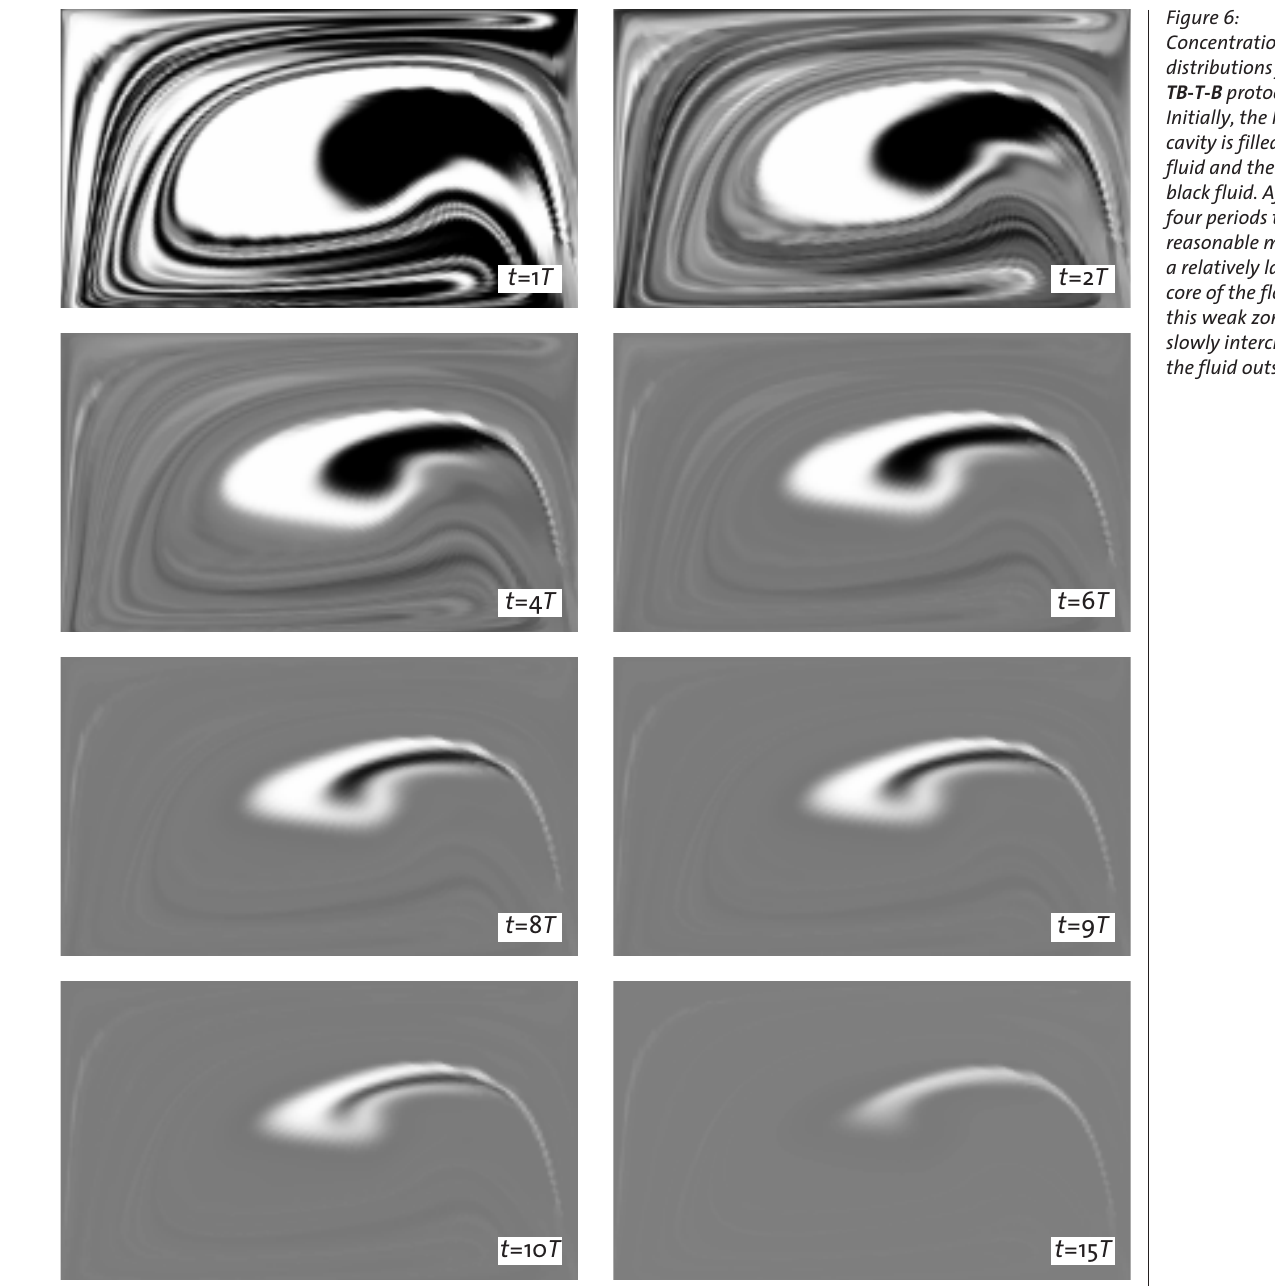
Figure 6: Concentration distributions for the TB-T-B protocol with D = 9. Initially, the left half of the cavity is filled with white fluid and the right half with black fluid. After already four periods the fluids are reasonable mixed except for a relatively large zone in the core of the flow. The fluid in this weak zone is only slowly interchanged with the fluid outside this